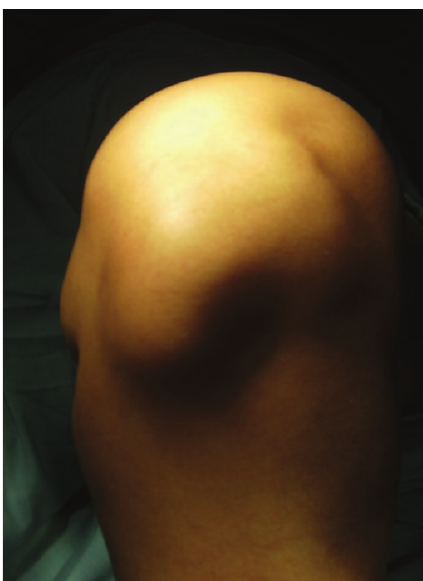
Figure 1: Clinical photograph.